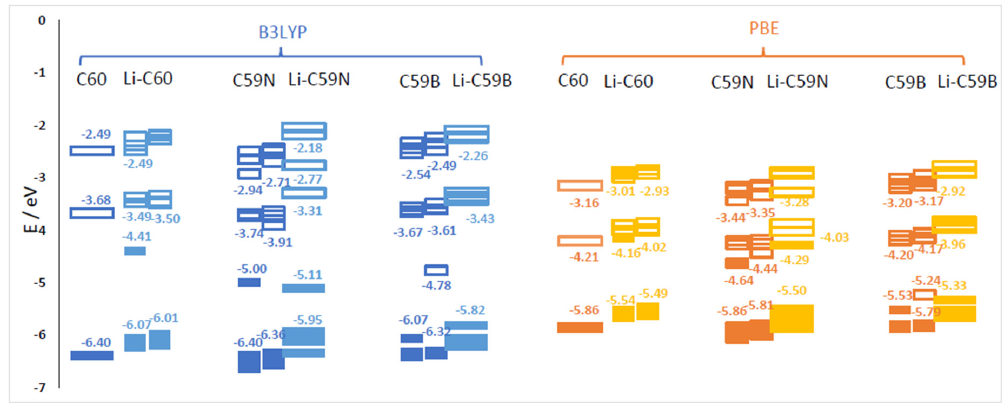
Figure 1. Energies of selected molecular orbitals (MOs) of C 60 , C 59 N, C 59 B and corresponding molecules with one Li attachment computed with B3LYP and PBE functionals. The filled symbols denote occupied MOs and the empty ones unoccupied MOs. For open-shell cases, both alpha (left) and beta (right) spin channel MOs are shown.